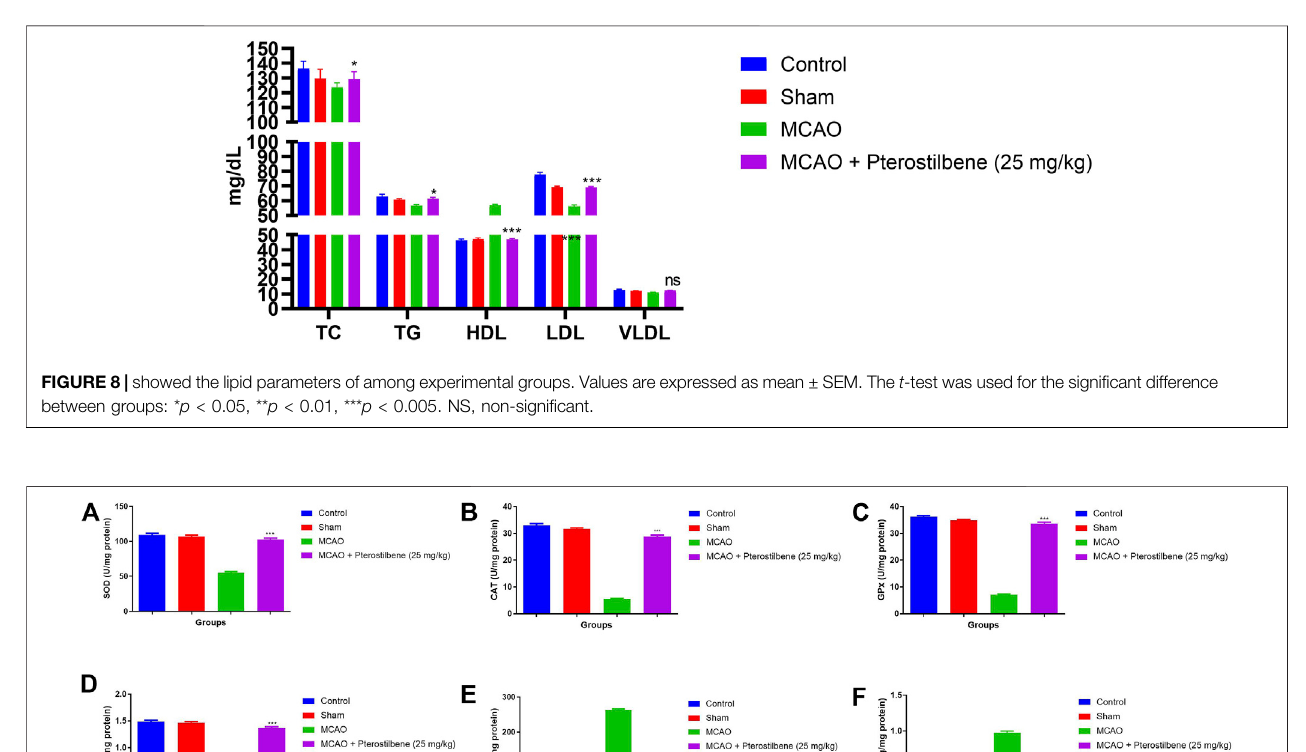
swelling, cellular disintegration, macrophage in fi ltration, monocyte in fi ltration and polymorphonuclear leucocyte degranulation.